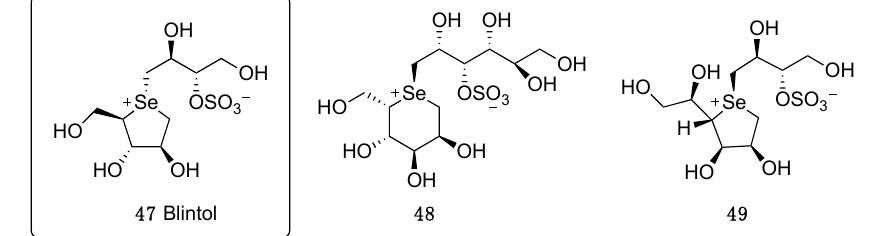
Figure 5. Structures of selenosugars 47–49 .